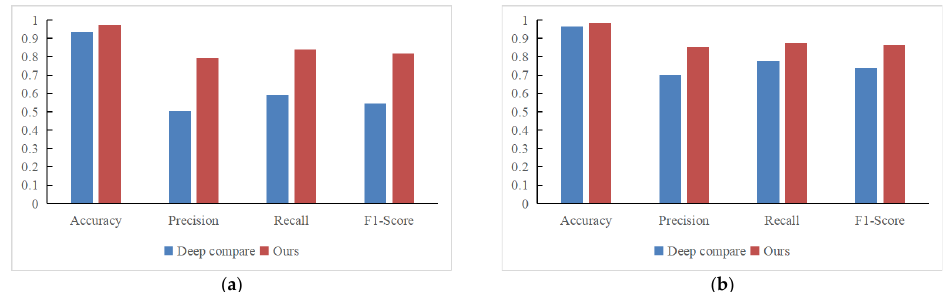
Figure 13. Performance comparison between the fruit matching model and the comparative model. ( a ) Performance comparison for apples matching. ( b ) Performance comparison for oranges matching.